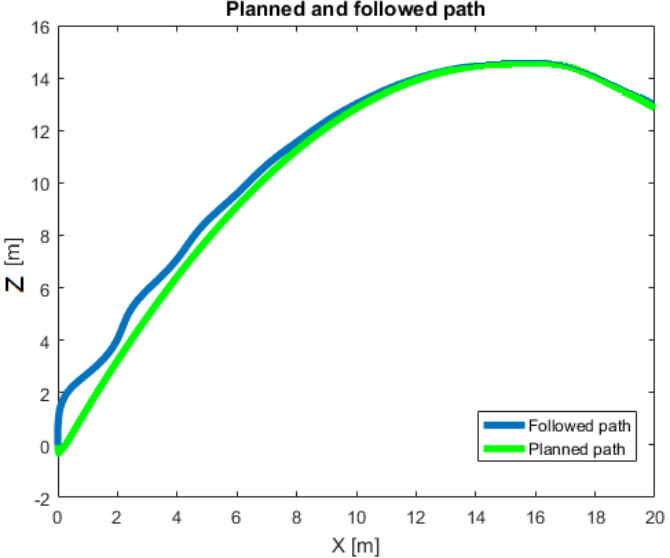
Figure 5. Path planned (green) and followed (blue) by the quadrotor in XZ plane under control of the MPC-PD control system.